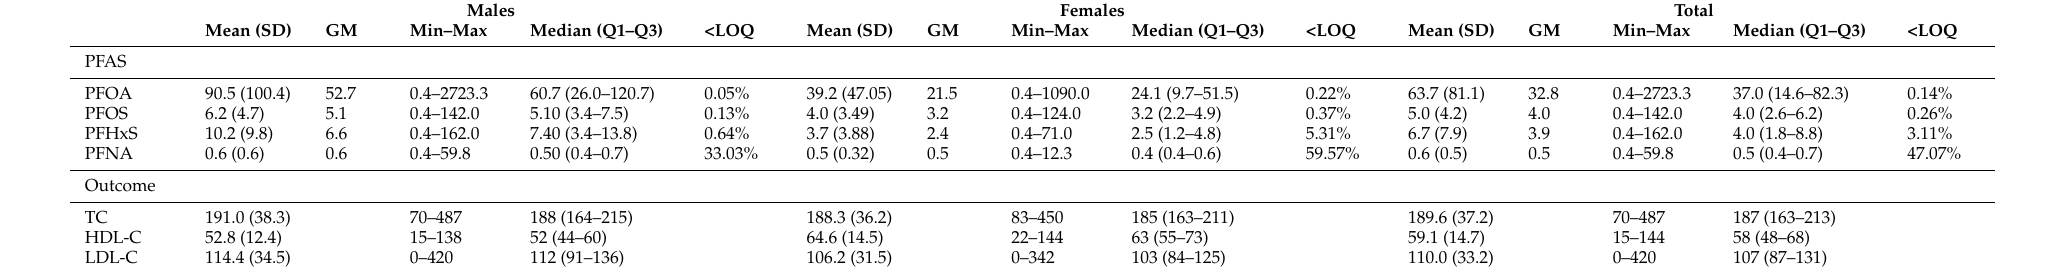
Table 1. Distributions of serum PFASs concentrations (ng/mL) and serum lipids concentrations (mg/dL) in the study population ( n = 34,633), stratified by